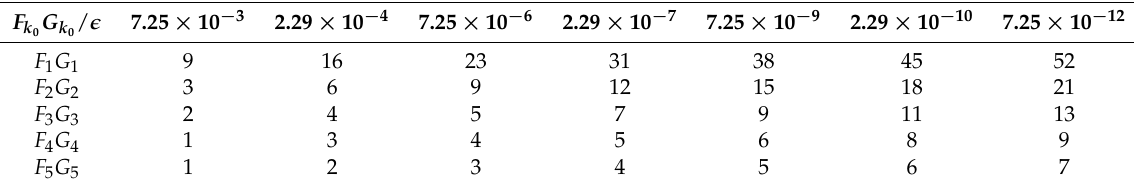
Table 8. Subdivision depth of 3-point ternary subdivision surfaces.